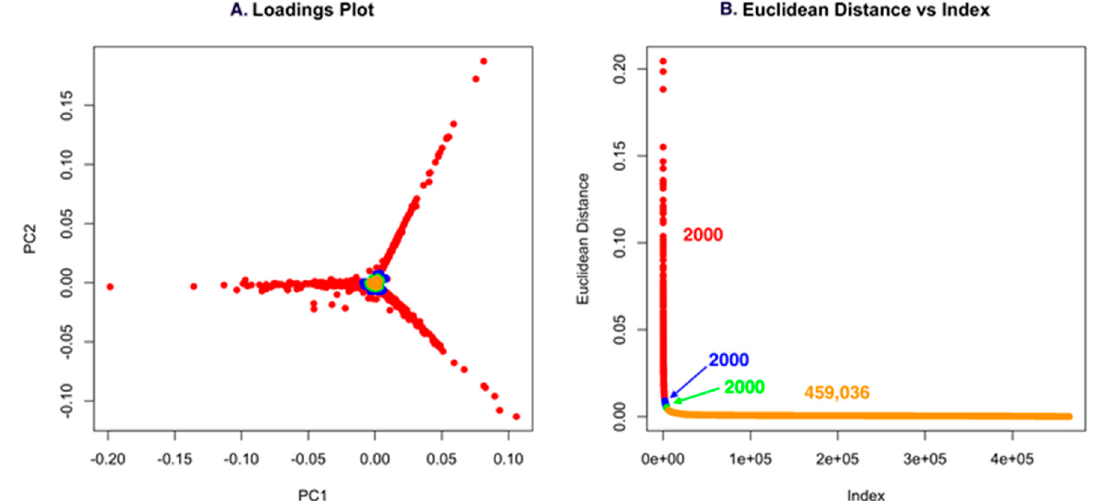
Figure 4. ( A ) The loadings plot for Dataset one with the 2000 most unique features colored in red; ( B ) The Euclidean distance versus index plot is color-coded to match the points in the loadings plot. This example shows that 459,036 features are located in the center of the PCA plot and, based on Euclidean distance, contribute little to variance, meaning that they are not unique to any strain.